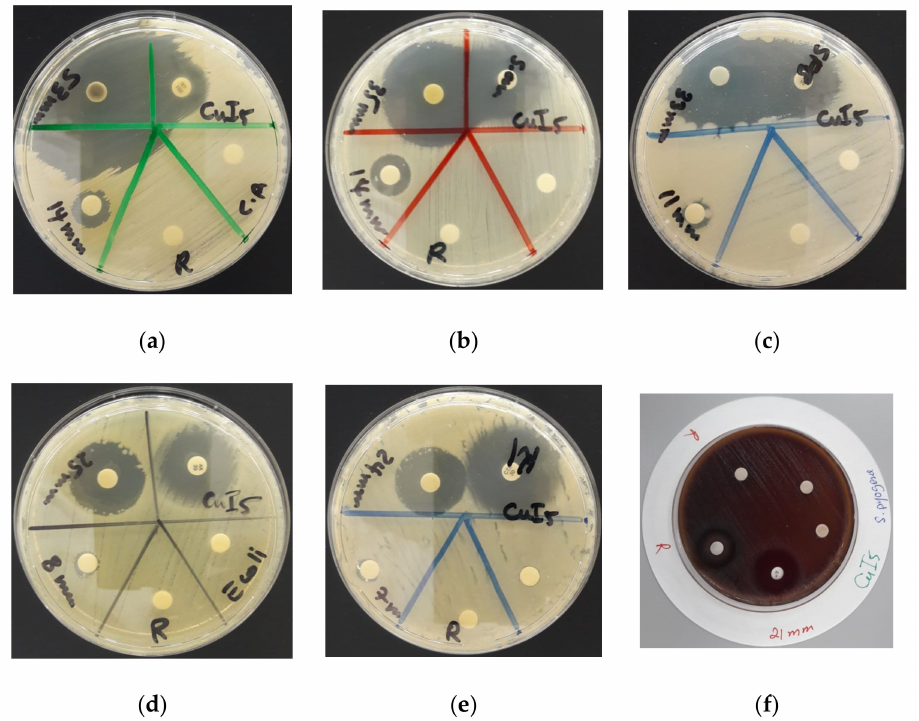
Figure 6. Disc diffusion methods of [Cu(12-crown-4) 5 (H 2 O) 6 ]I 6 · 2I 2 with positive controls (antibiotic). From left to right: [Cu(12-crown-4) 5 (H 2 O) 6 ]I 6 · 2I 2 against ( a ) C. albicans WDCM 00054 ; ( b ) S. aureus ATCC 25932; ( c ) B. subtilis WDCM 00003; ( d ) E. coli WDCM 00013; ( e ) K. pneumoniae WDCM 00097 ; ( f ) S. pyogenes ATCC 19615